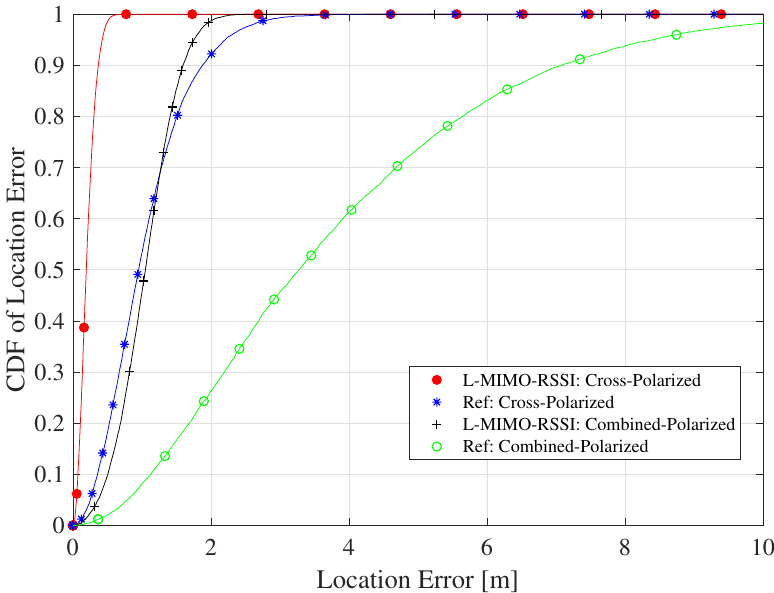
Figure 11. The CDF of localization RMSE for the proposed algorithm for the LOS environment and the cross- and combined polarized antenna